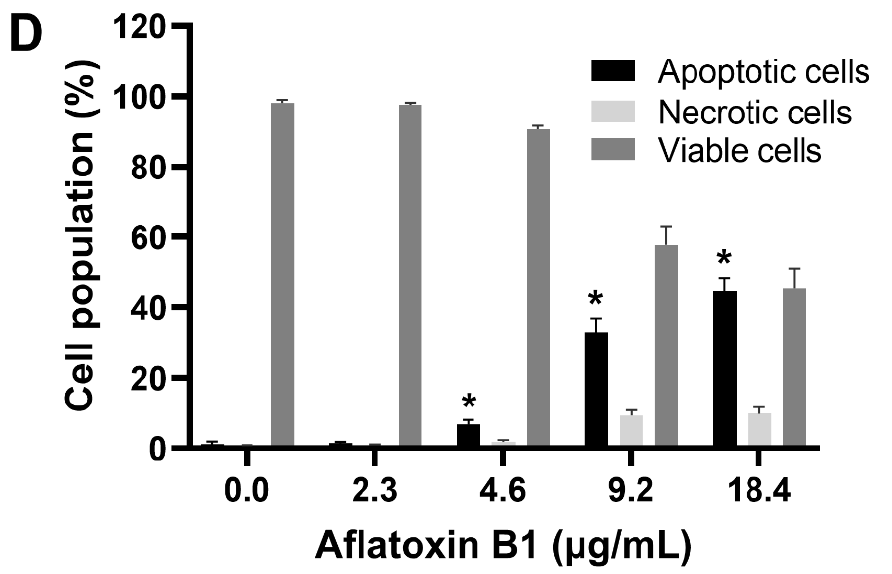
Figure 1. Cell viability and cell death analyses of MCF7 ( A , C ) and MCF10A ( B , D ) cells after treatment with aflatoxin B1. * p < 0.05 compared to control.